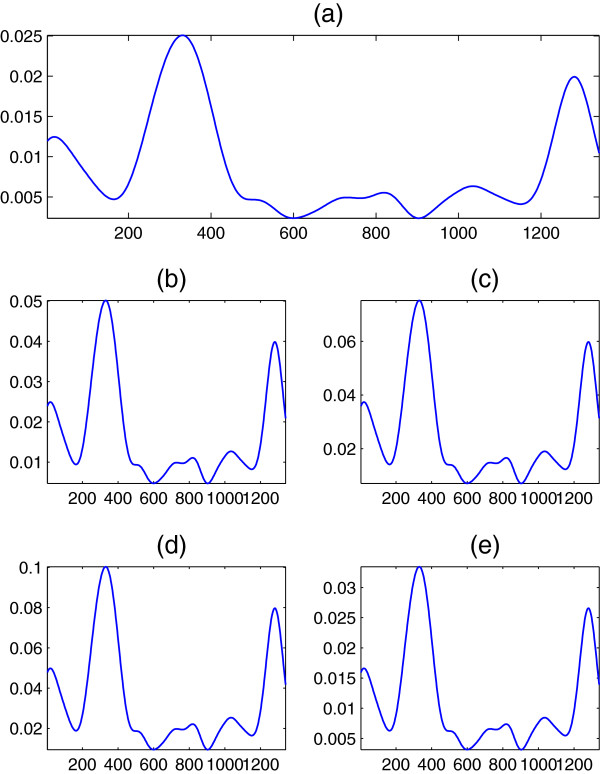
DNA spectrumS~d(n)withh~set to a Blackman window at
R
= 3 of the DNA sequence ALOEGLOBIM when (a) Voss, (b) tetrahedral, (c) quaternion, (d)
Z
-curve, and (e) simplex mappings are used.